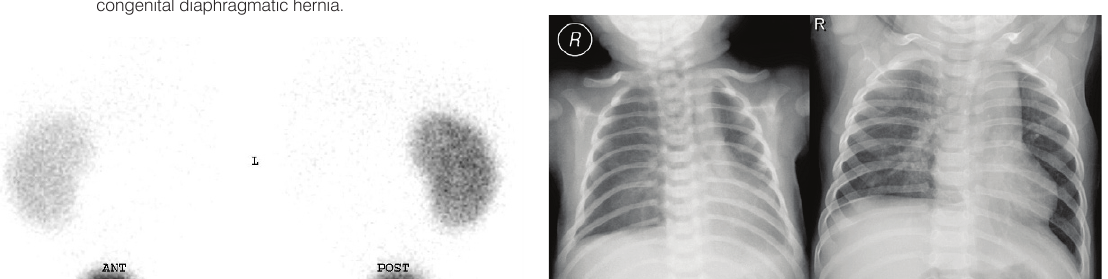
Figure 4. Follow-up chest radiographs postoperatively at 2 weeks (left) and at 8 months (right) show normal ventilation of the left